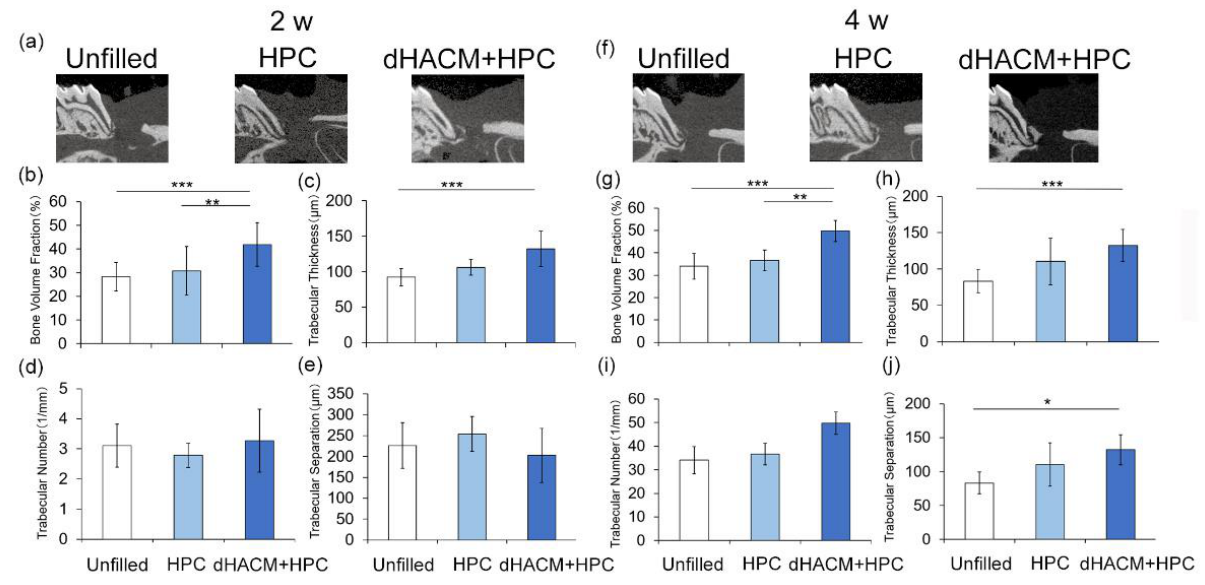
Figure 1. Two-dimensional images in micro-CT and quantitative analysis by 3-D structural analysis software (TRI/3D-BON). ( a , f ) A sagittal slice images from micro-CT at 2 and 4 weeks. Enhanced newly formed bone can be observed in the dHACM+HPC group at 2 and 4 weeks. ( b – e , g – j ) Quantitative analysis of micro-CT images by a 3-D structural analysis software (TRI/3D-BON). White bar, Unfilled group; Light blue bar, HPC group; Blue bar, dHACM+HPC group. bone volume fraction ( b , g ), trabecular number ( c , h ), trabecular separation ( d , i ) and thickness ( e , j ) were compared between groups. Data shown as mean ± SD ( n = 10). * p < 0.05, ** p < 0.01, *** p < 0.001 by Kruskal-Wallis test with Dunn’s post hoc test.